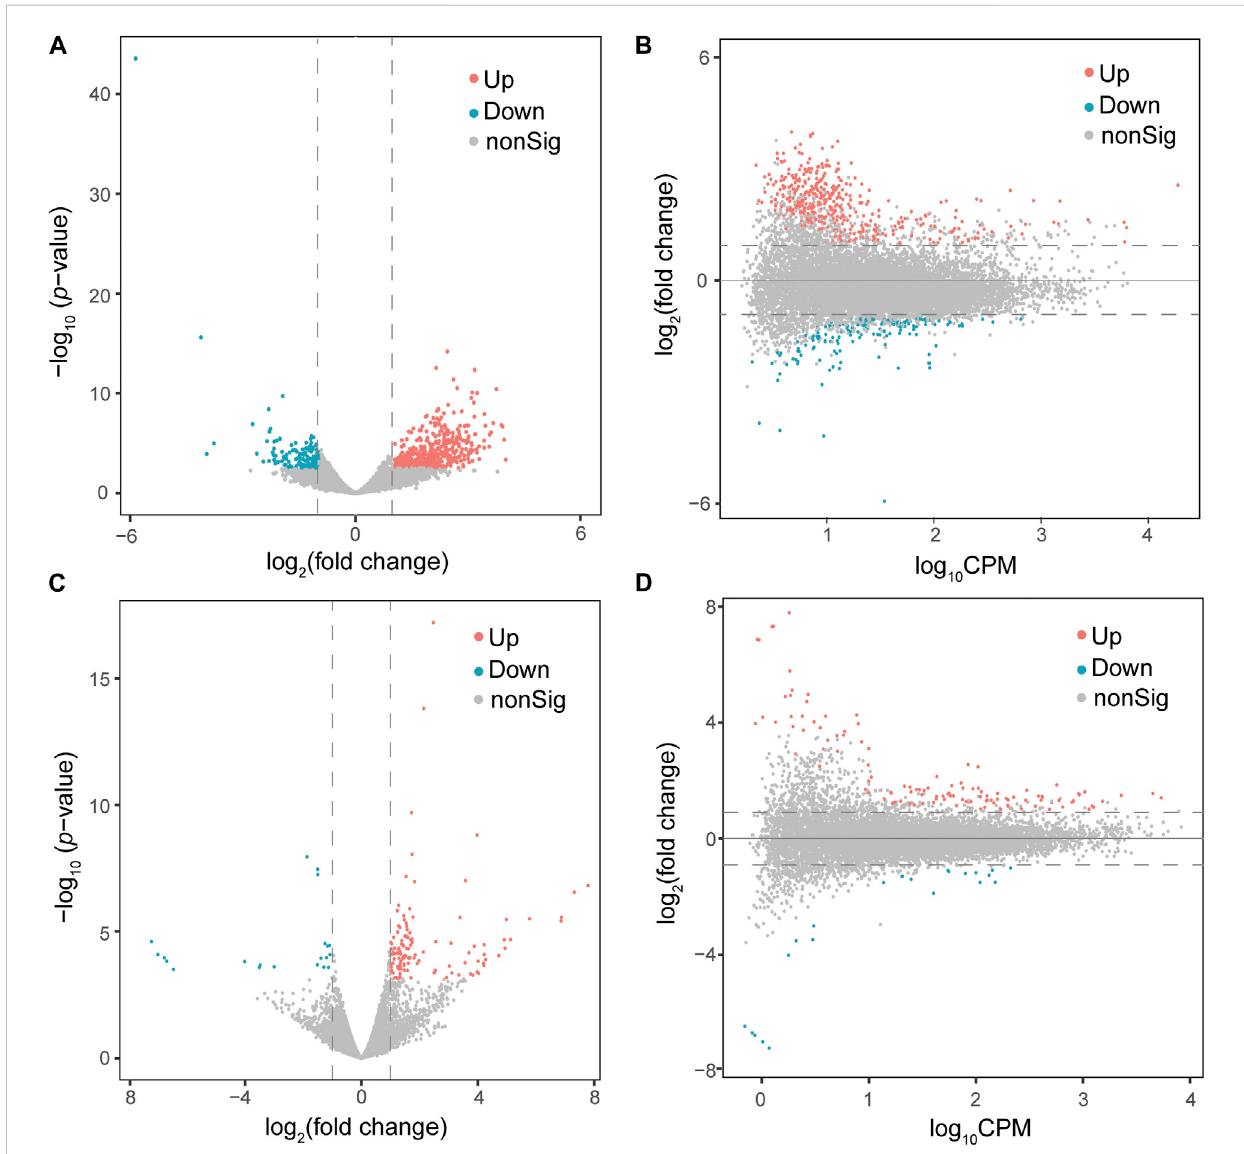
FIGURE 2 Differentialgeneexpressionanalysisofmale Monodelphisdomestica bloodculturesamplesfromthePFOA/GenXtreatmentandcontrolgroups. (A, C) Volcanoplotdemonstratingdifferentiallyexpressedgenes(DEGs)inthePFOA (A) andGenX (C) treatmentgroupscomparedtothecontrolgroup.Red dots represent signi fi cantly upregulated genes and blue dots represent signi fi cantly downregulated genes (FDR < 0.05 and |log 2 FoldChange| > 1). Grey dots represent non-signi fi cant genes. (B, D) MA plot demonstrating the DEGs in the PFOA (B) and GenX (D) treatment groups compared to the control group. The x -axis is log 10 CPM (log 10 Counts per Million). The y -axis is log 2 (Fold Change). The horizontal line indicates |log 2 FoldChange| = 1. Red dots indicate genes with signi fi cantly increased expression in the PFOA treatment group compared to the control group, and blue dots indicate genes with signi fi cantly decreased expression (FDR < 0.05 and |log 2 FoldChange| > 1).